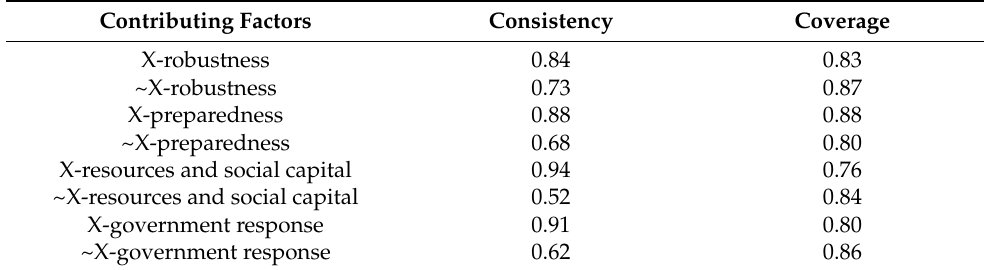
Table 6. Necessary condition